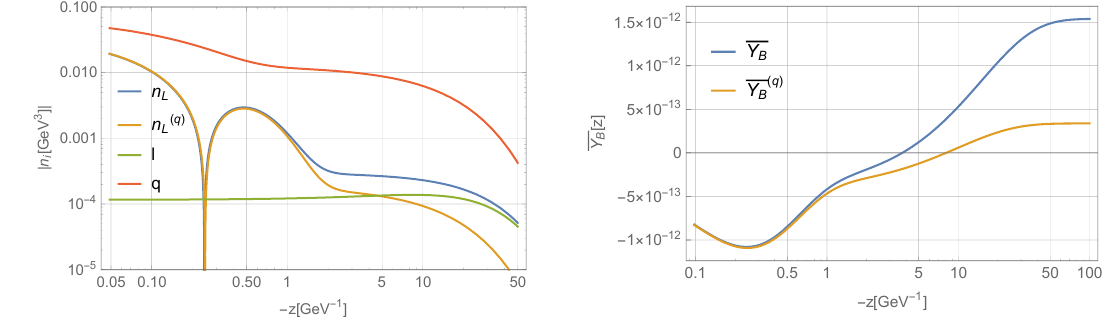
Figure 2 . Left plot: absolute value of the number densities n L , n ( q ) , l , and q in the symmetric L phase for a top source. The computation includes top, bottom and tau Yukawa interactions. Right plot: baryon asymmetry (cid:22) Y B ( z ) and (cid:22) Y ( q ) ( z ) as a function of the integration B